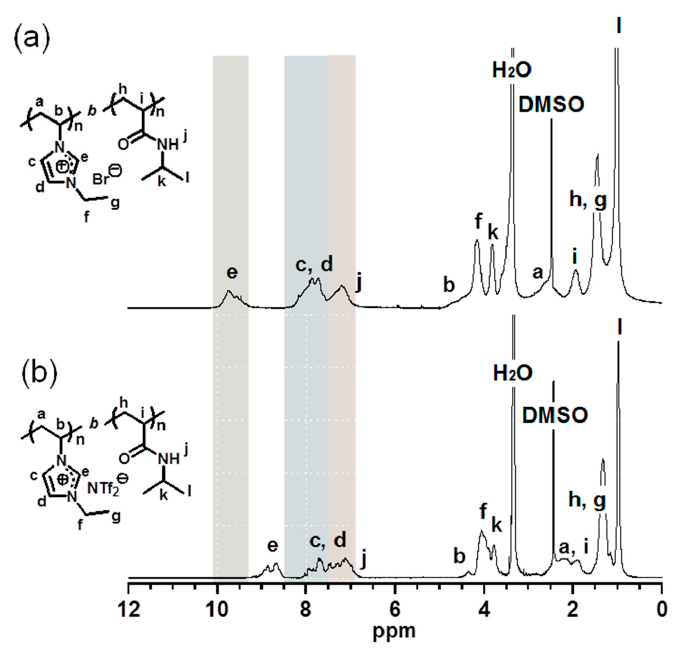
Figure 1. 1 H NMR spectra (DMSO- d 6 ) of ( a ) poly(NVI-Br) - b -poly(NIPAM) and ( b ) Figure poly(NVI-NTf 2 ) - b -poly(NIPAM) .